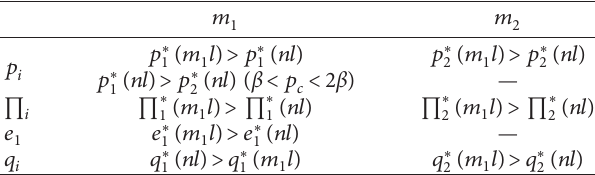
Table 3: Comparison of optimal decisions and profits of the two